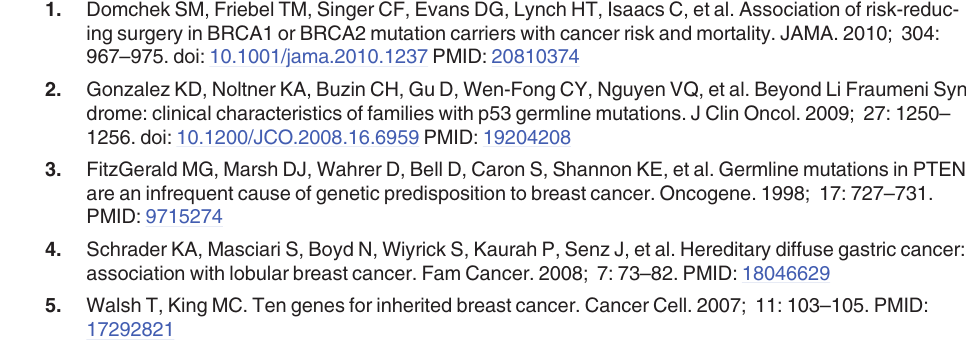
S1 Table. List of genes tested in this study. S2 Table. Genomic information of genes referenced in this study. S3 Table. Next generation sequencing metrics and